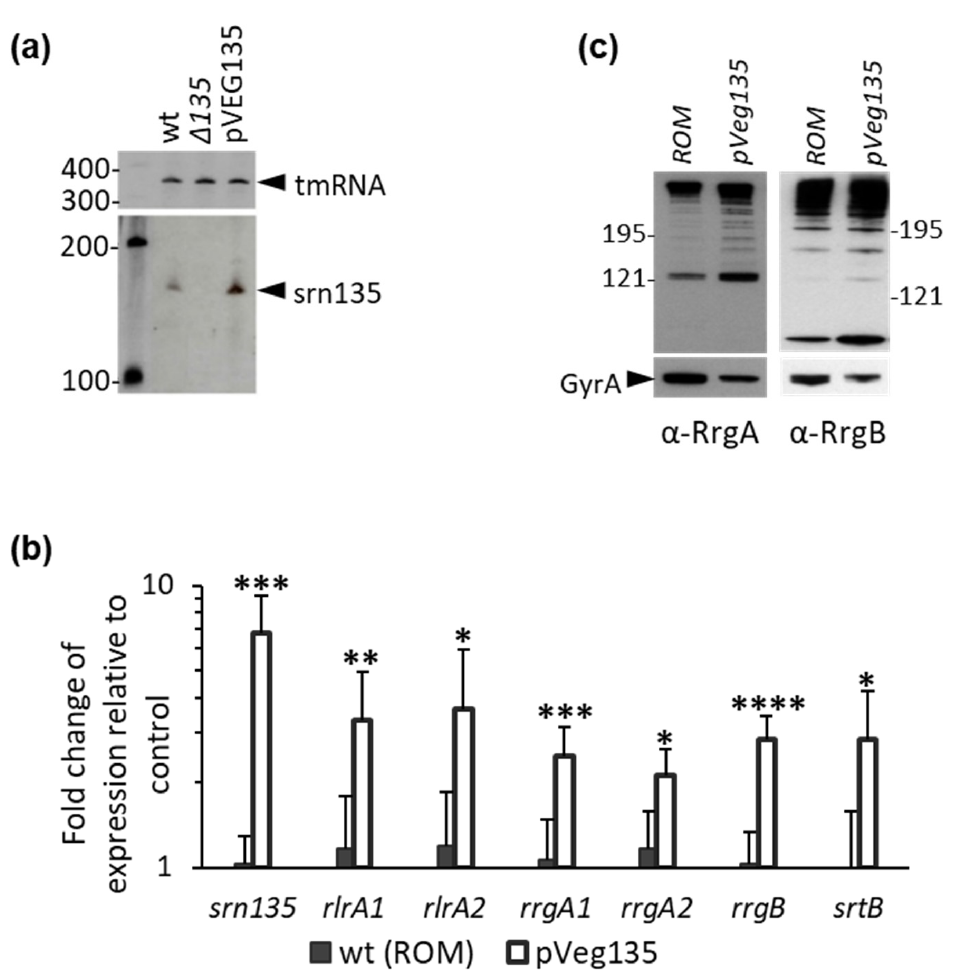
strain (R6 rlrA (pveg135)) exhibited 2.7-fold higher levels of rlrA transcript compared to the non- srn135 -containing strain (R6 rlrA (pROM)) (Figure 5d). The differences observed between the two strains were not influenced by the bimodal expression of pilus and are exclusively due to the presence of srn135 , confirming the positive regulation of srn135 on the rlrA levels.